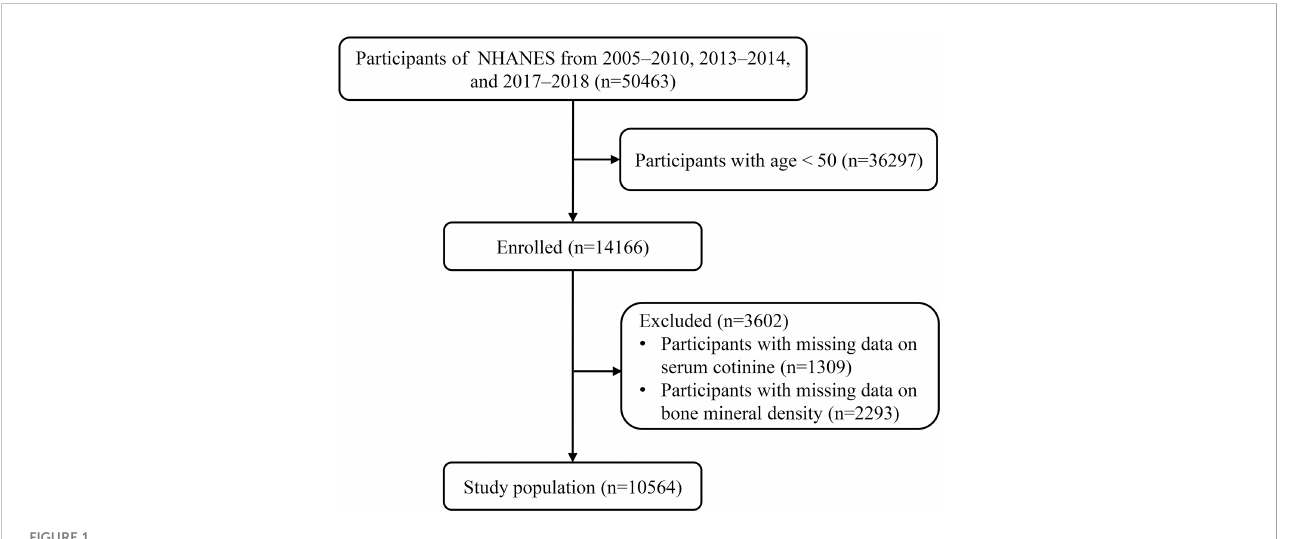
FIGURE 1 The fl ow chart of selection of included